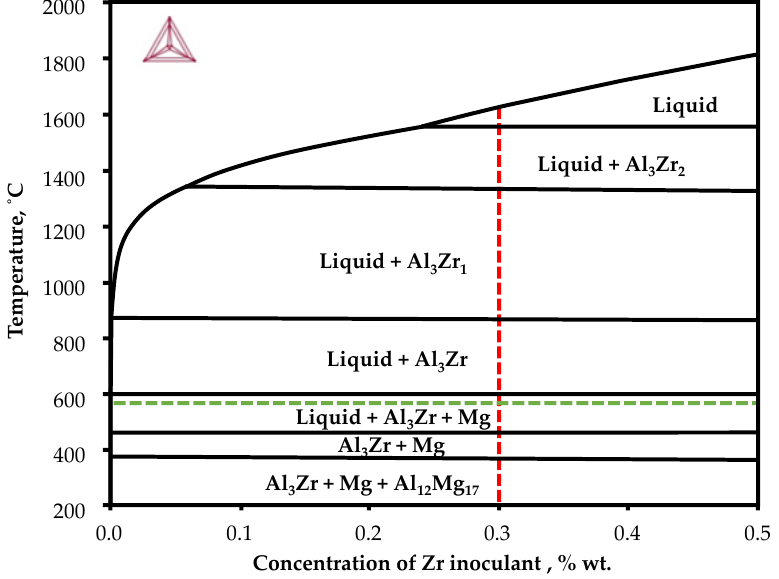
Figure 9. Theoretical phase diagram of Mg + 9 wt % of Al + 1 wt % of Zn + 0.0–0.5 wt % Zr calculated using ThermoCalc software.